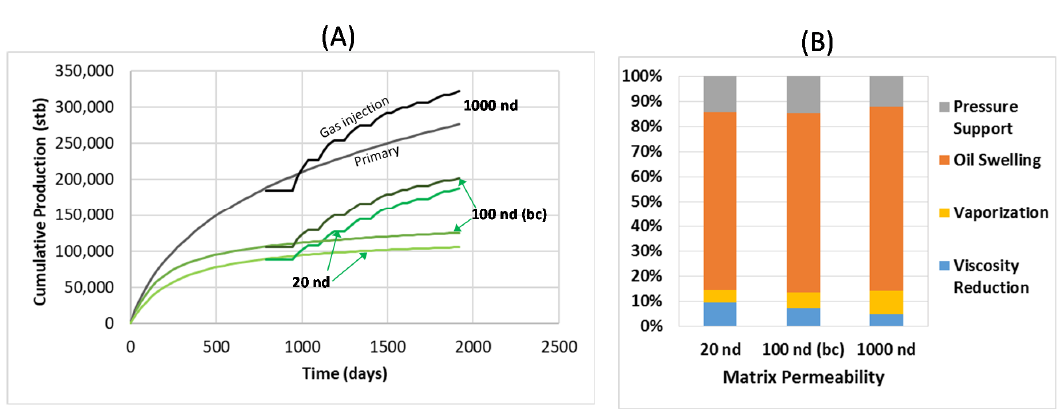
Figure 19. ( A ) Cumulative oil recovery for cases with different matrix permeability values, and ( B ) the relative importance of different recovery mechanisms for models with different matrix permeability.